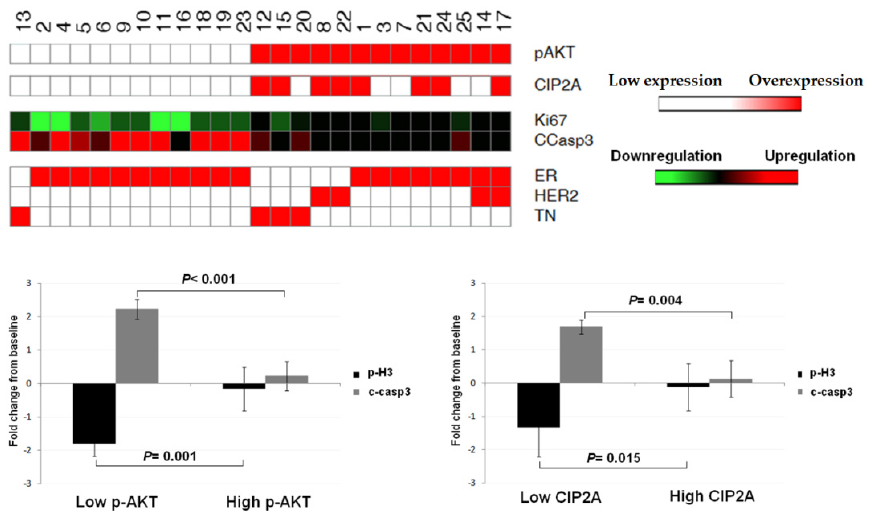
Figure 4. Correlation between p-AKT, CIP2A, phosphorylated H3, and cleaved Caspase 3 in 25 fresh breast cancer specimens treatedex vivowith doxorubicin; pH3: phosphorylated Histone H3; c-casp3: cleaved Caspase 3.